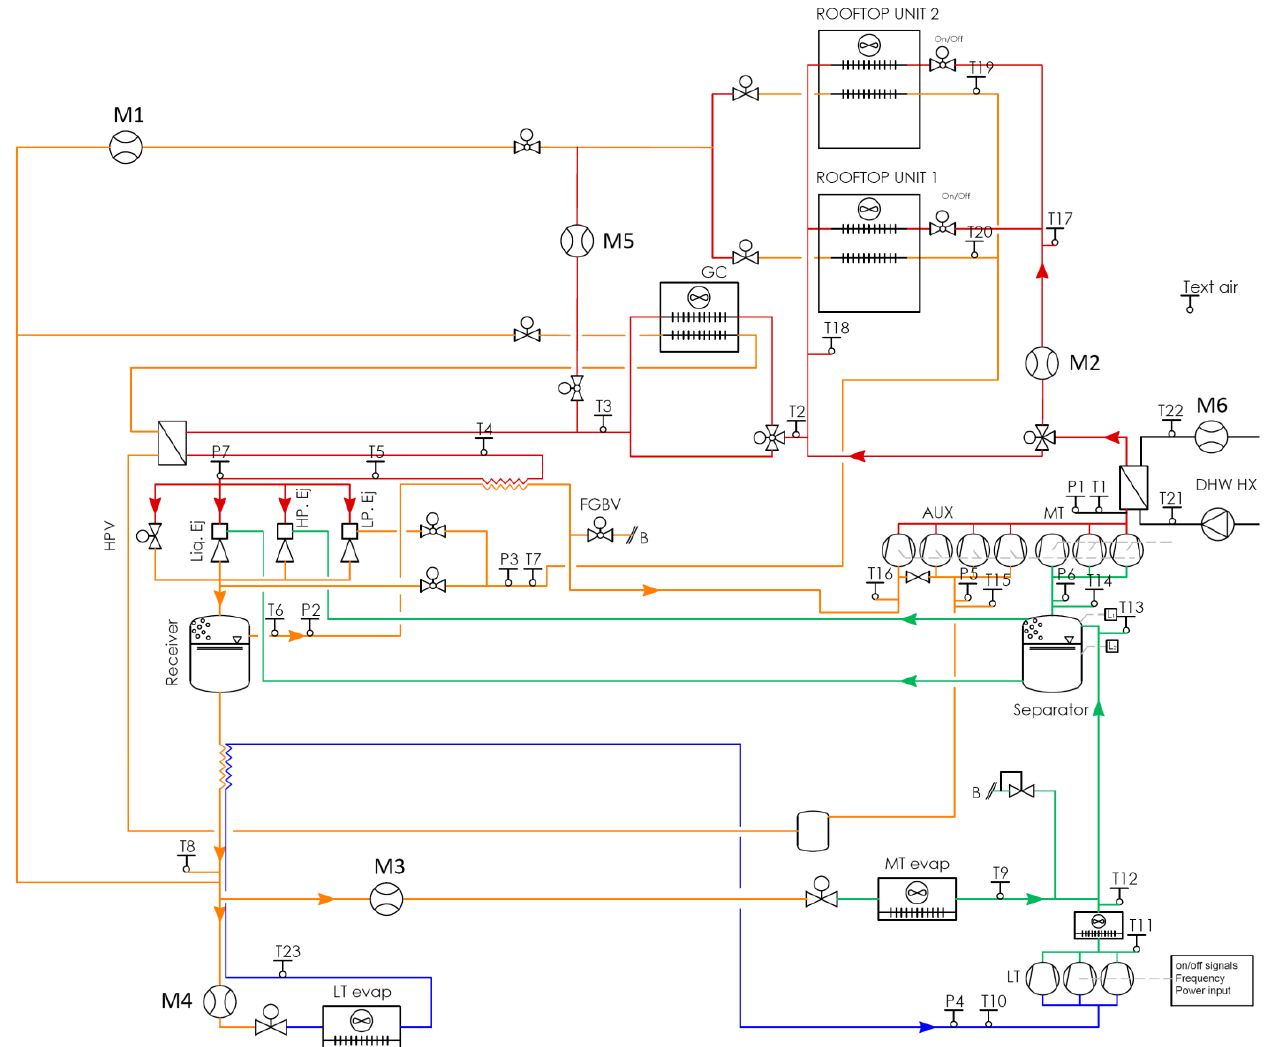
Figure 1. System layout of the integrated CO 2 refrigeration system installed for the supermarket in Porto de Mos.